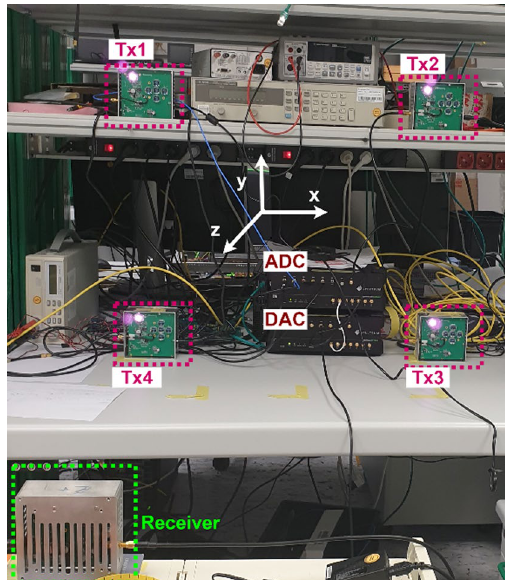
Fig. 5 Measurement set-up for 3D evaluation